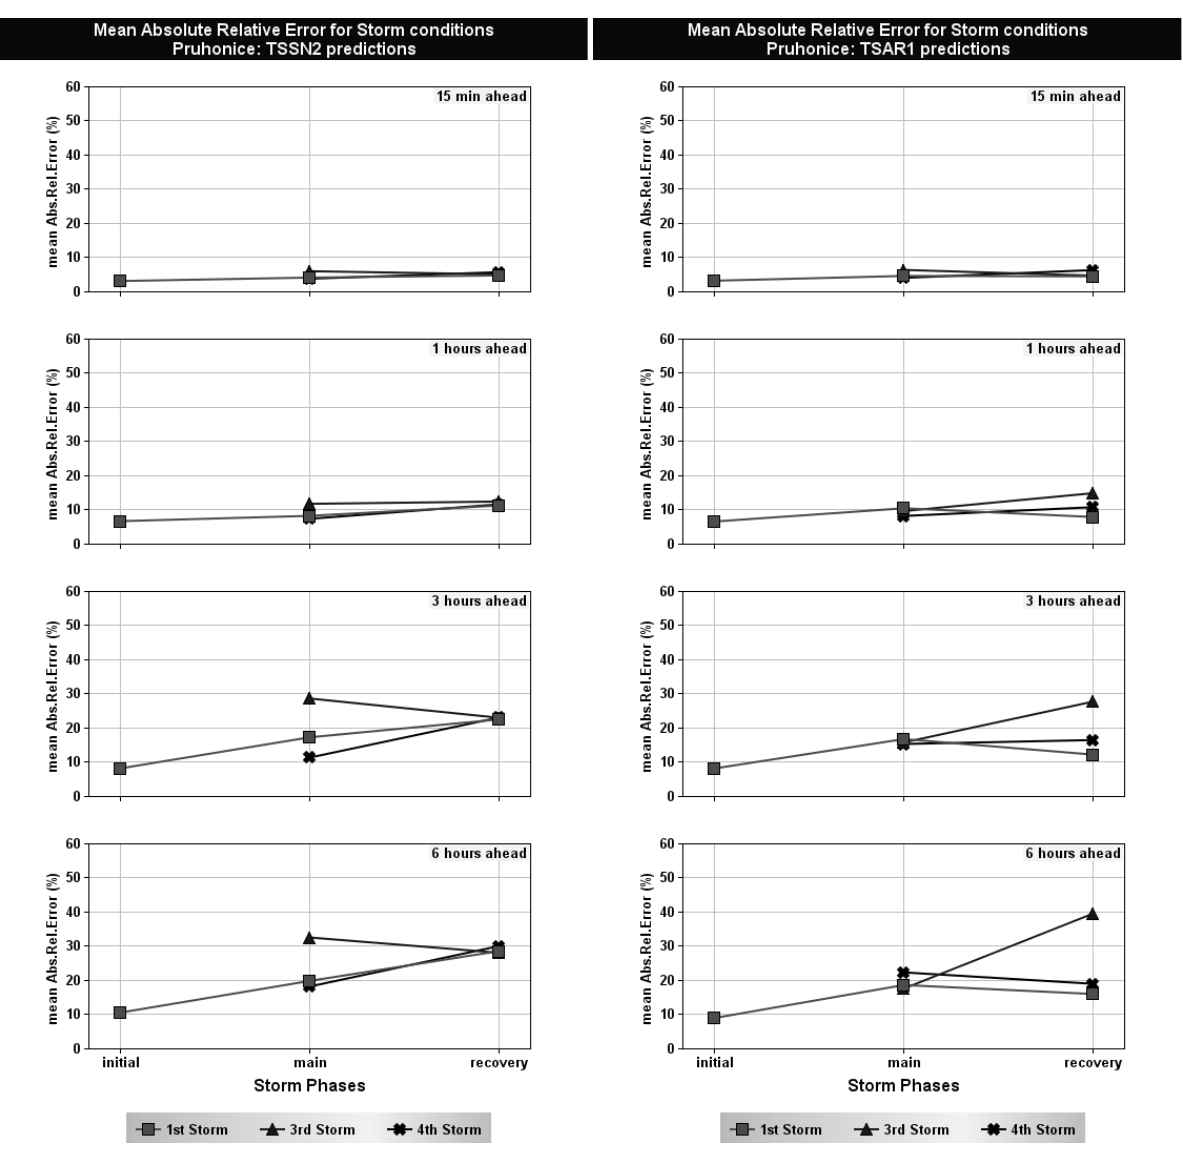
Fig. 6. The same as Fig. 5 for Pruhonice